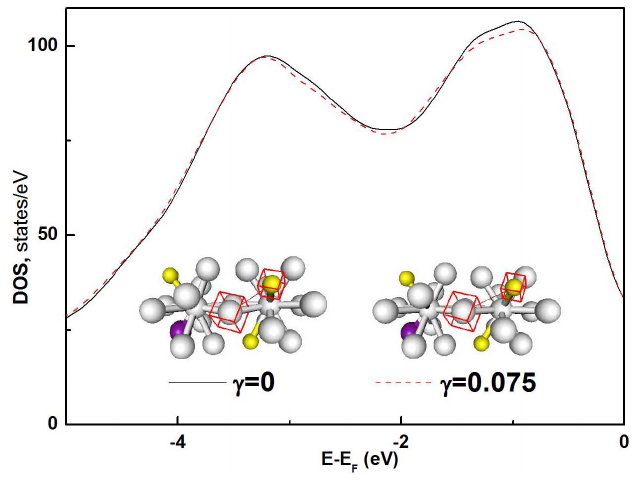
Figure 6. The majority-spin DOS of un-deformed (  = 0) and deformed (  = 0.075) Fe-Si-B glassy alloys at 0.4–3.0 eV below the Fermi level. The insets show the icosahedral clusters of atoms in the glassy alloys. Grey, yellow and brown spheres represent Fe, B and Si atoms, respectively. The Fe-B bond whose bond length changes with applied shear strain is indicated by a thin line and atoms of this bond are indicated by the red